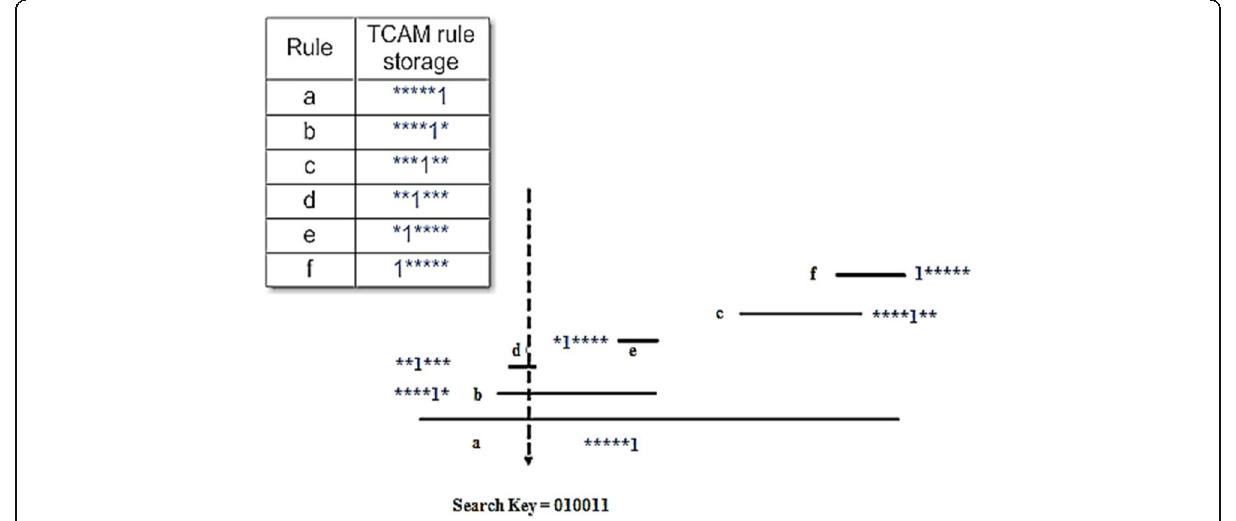
Fig. 1 An example of encoding using the basic scheme of dependent encoding proposed by Liu